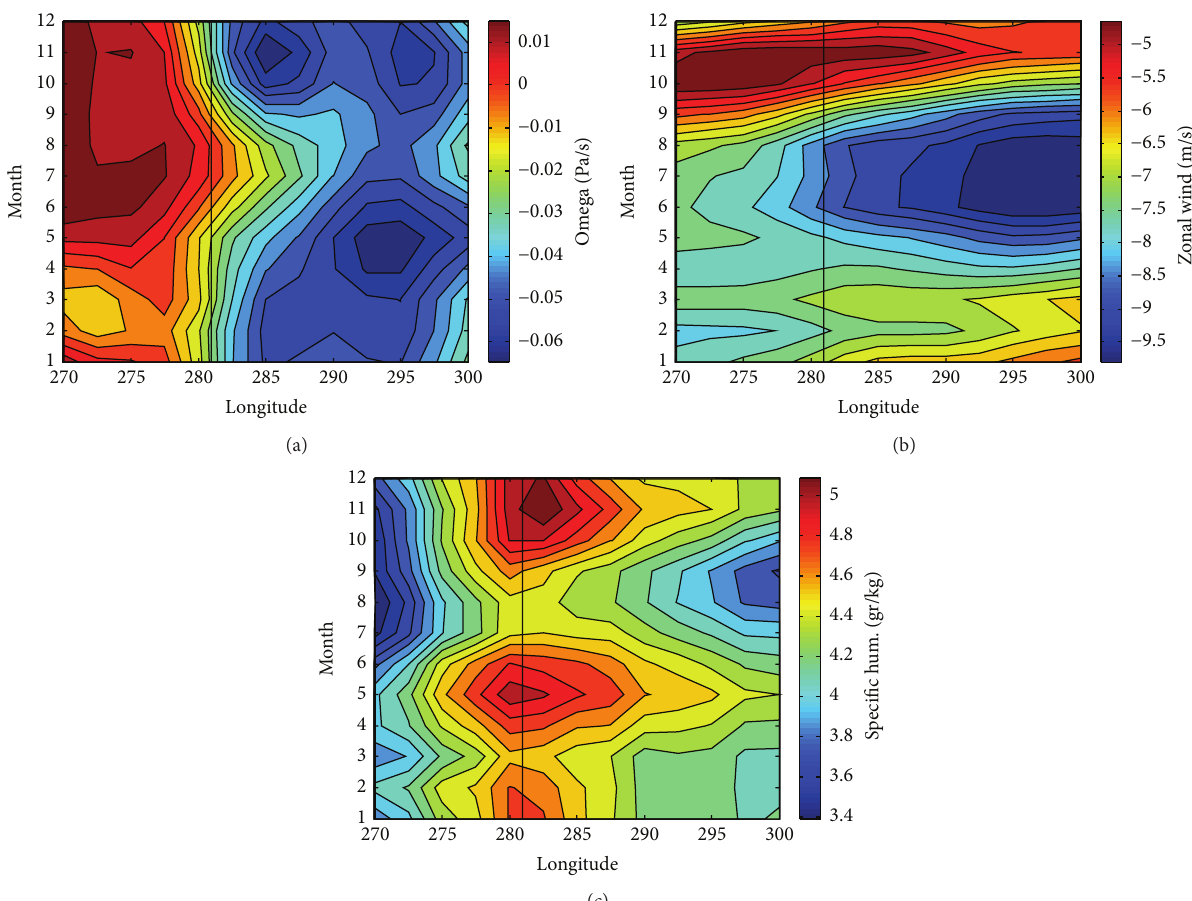
Figure 5: Hovm¨oller diagram across a longitudinal transect from 270E to 300E averaged from 5S to 5N of (a) omega 600 hPa, (b) zonal velocity wind 600 hPa, and (c) specific humidity 600 hPa versus the months of the year. The black line located at 281E represents the Paute